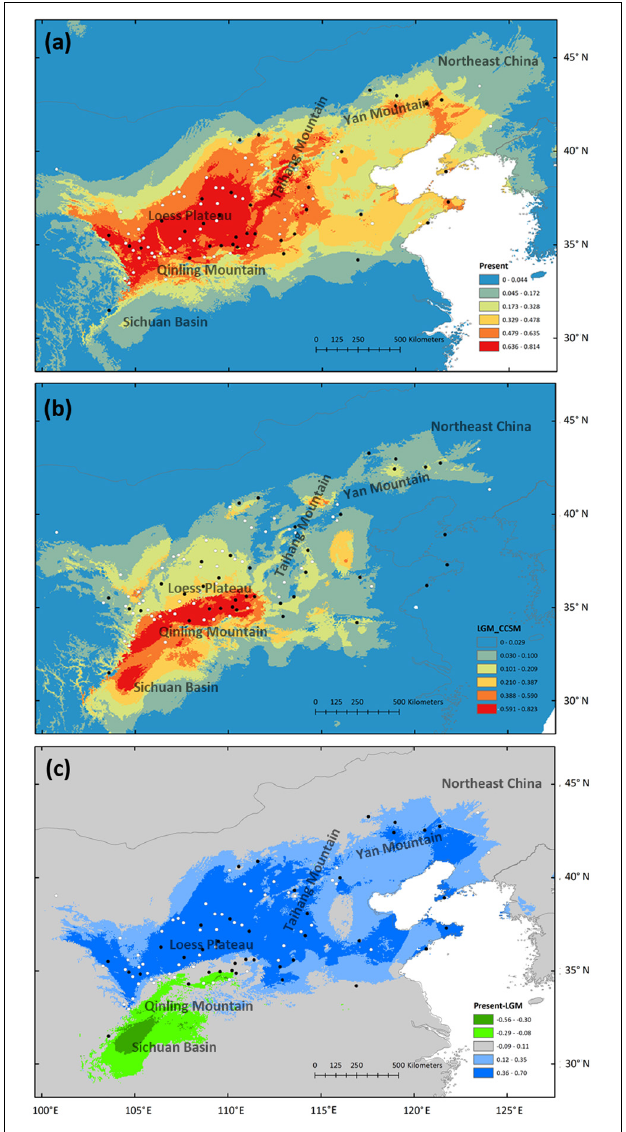
FIGURE 5 | Potential species distribution of Speranskia tuberculata estimated by ecological niche modeling at present (a) and during the last glacial maximum (LGM) using the CCSM3 model (b) . Absolute changes in habitat suitability are compared between present and LGM (c) ; Blue represents suitability gains and green represents losses in suitability. Black dots represent locations of sampled populations, while white dots represent occurrence points collected from herbarium records.